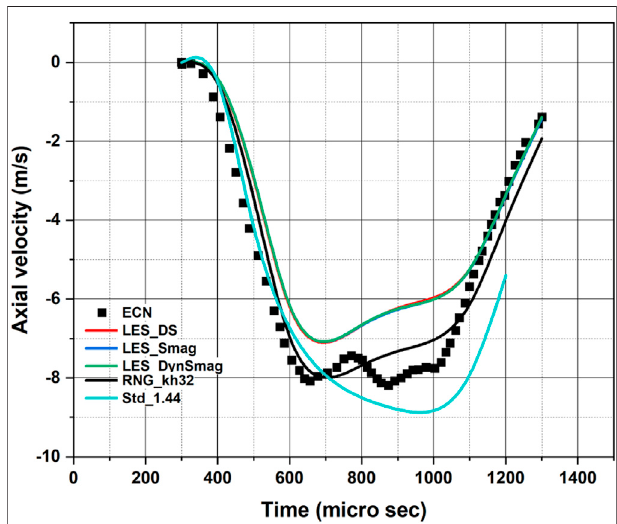
FIGURE 9 | Comparison of the predictions of axial velocity of the gas in the chamber during the spray injection using with the experimental data of (Sphicas et al., 2017) [Standard k – ε turbulence model used with C ε 1 = 1.35, 1.40, and 1.44; B 1 =5, C bl =2.5, cone-angle 25 ° , plume targeting angle 35 ° and all other cases with B 1 = 32, C bl = 16, cone-angle 25 ° , plume targeting angle 35 °